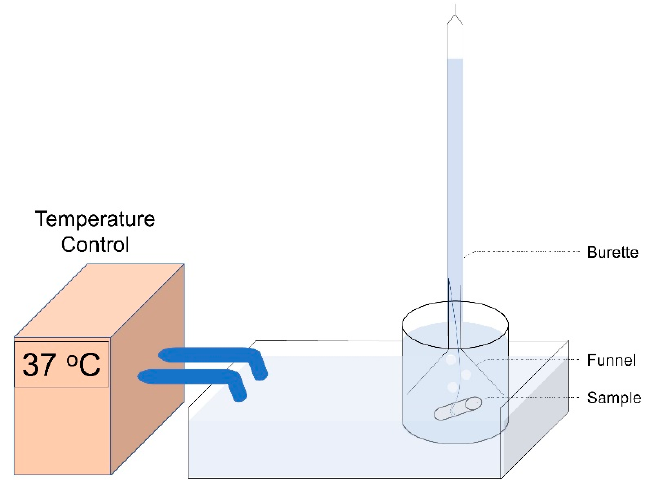
Figure 1. Schematic of the hydrogen evolution setup for Mg samples, maintained at 37 °C with a water bath.